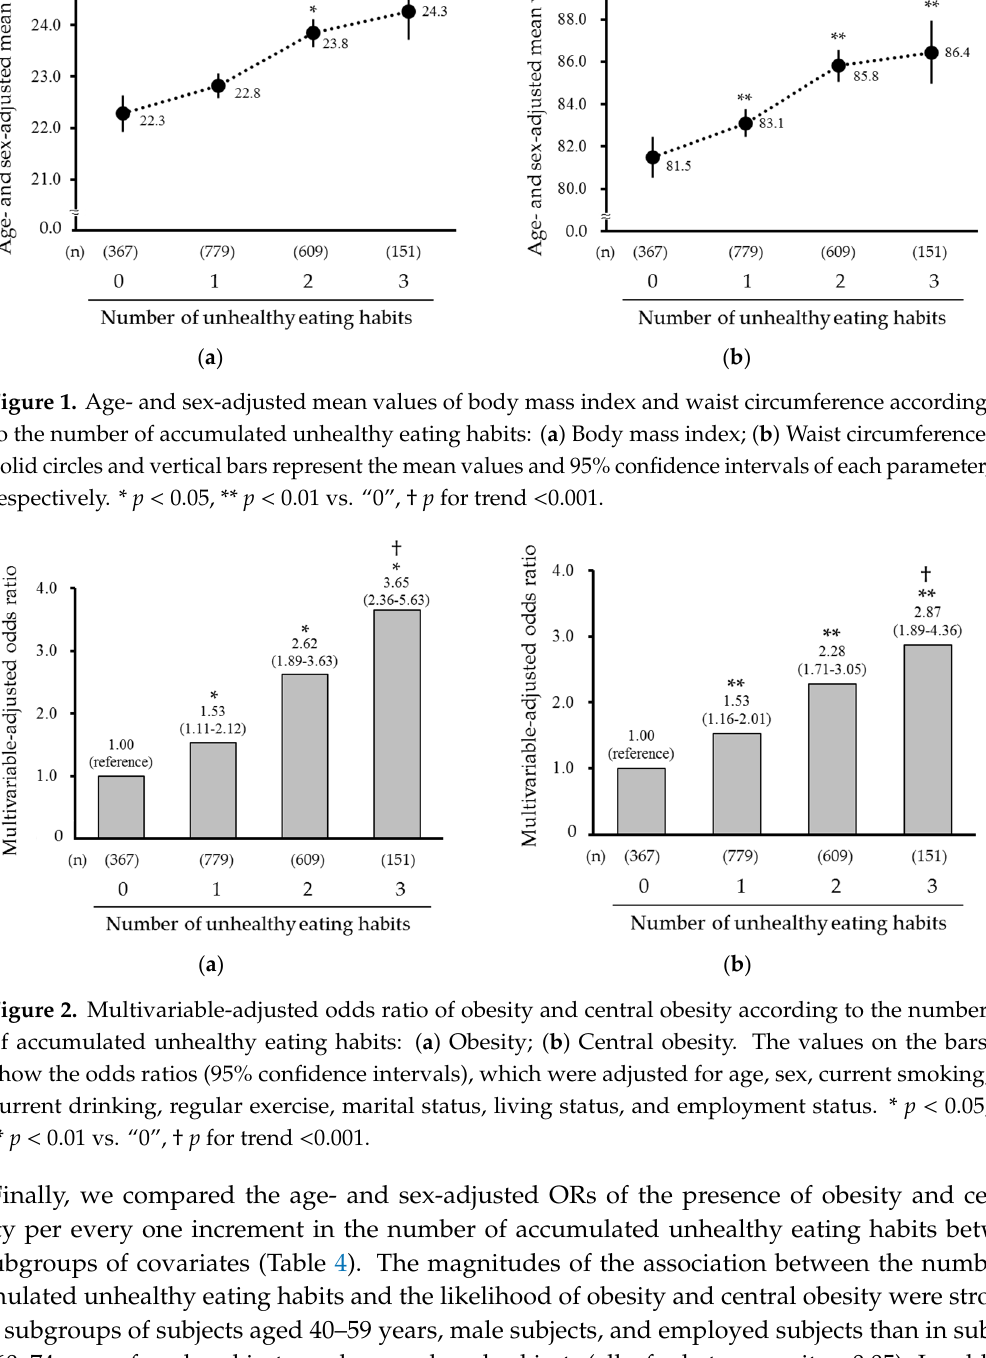
Values are expressed as adjusted mean (standard error), or frequency. Mean values of age were adjusted for sex. Frequencies of women were adjusted for age.